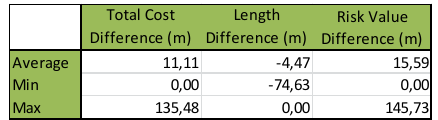
Figure 2: Comparison of the results of LRP versus SP algorithm over the entire indoor